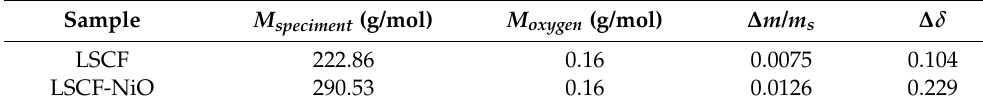
Table 1. Oxygen stoichiometric for LSCF and